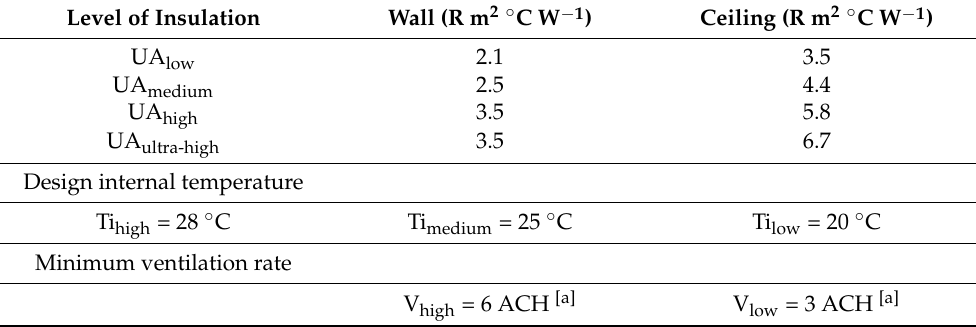
Table 10. Sensitivity analysis inputs for R values, internal building temperature, and minimum ventilation rate. Recommended levels of insulation for homes based on climate [3].